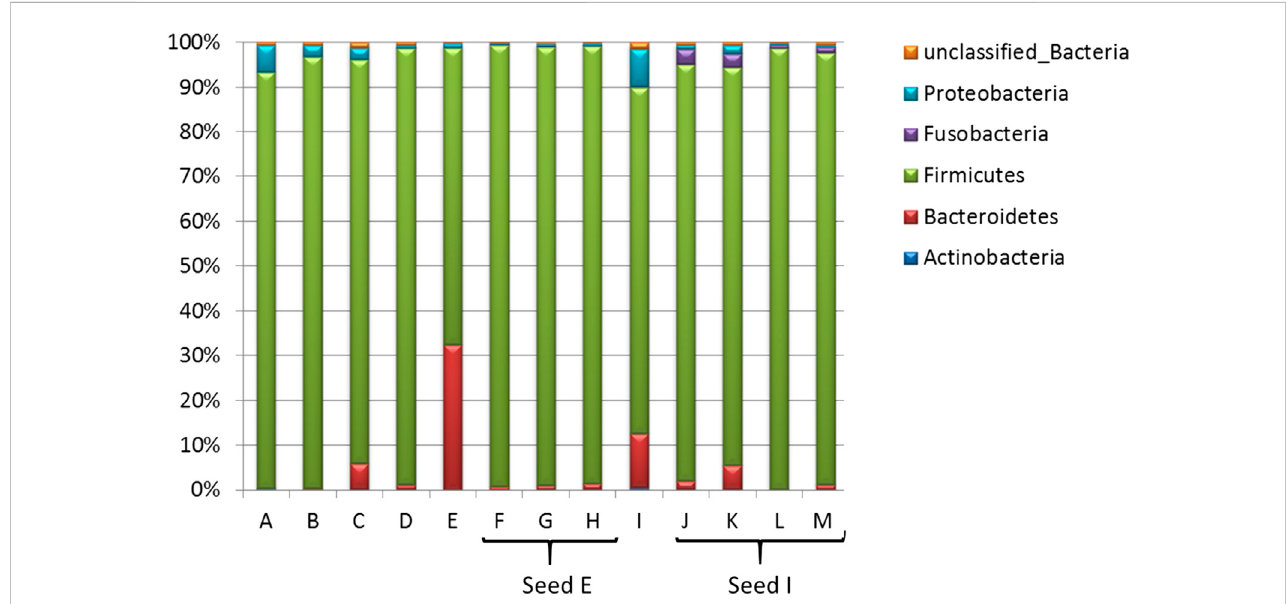
FIGURE 3 Bacterial composition of competitive exclusion master seed, seed stocks and derived commercial lots at the phyla